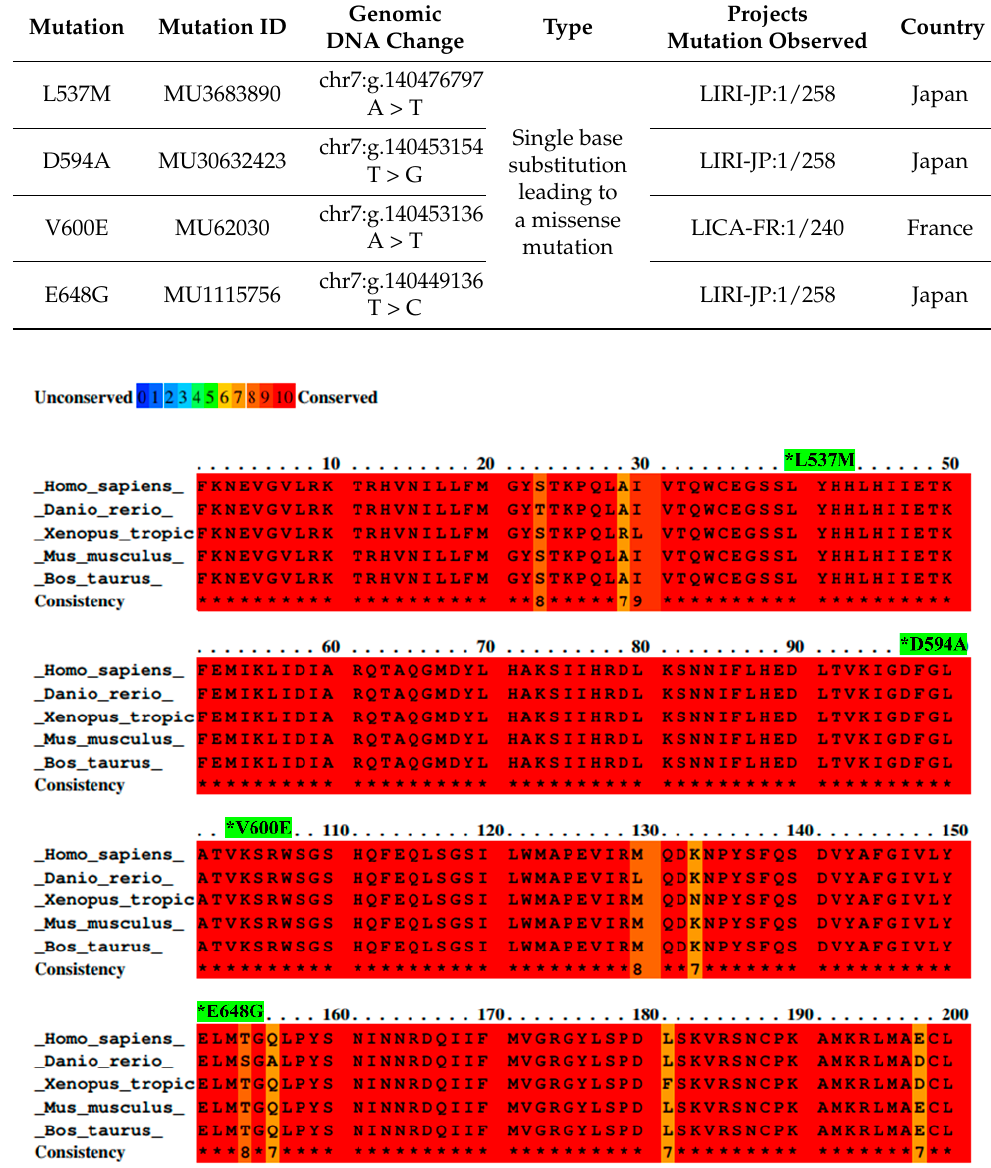
Table 1. BRAF mutations were identified by ICGC and subjected to functional analysis.